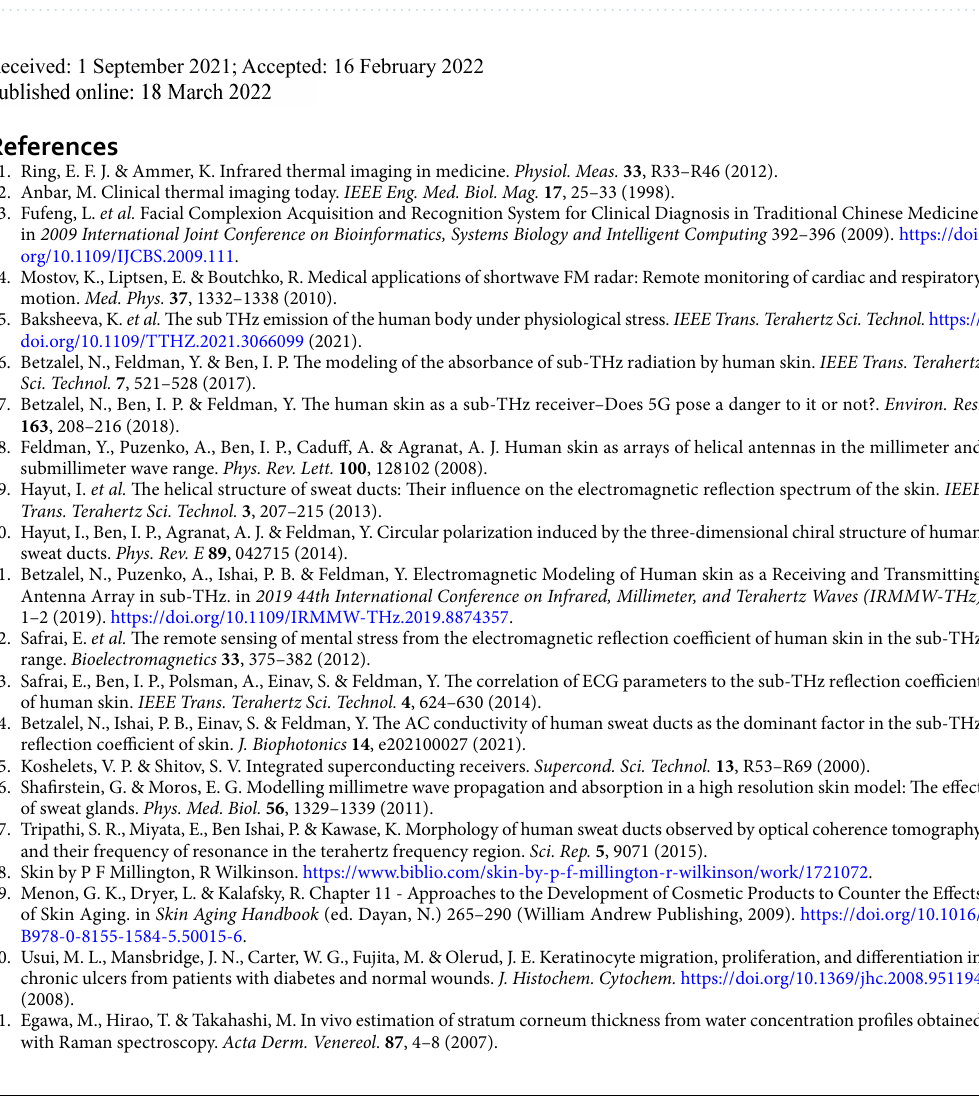
Figure 12. Comparison of the normalized skin brightness temperature calculated by CST simulations (Red) and by in vivo radiometric measurements of the skin thermal radiation (Black) 5 . The measurements accuracy is ± 1.7 degree. It can be seen that qualitatively the simulation and experiment results are having the same nature and follow the same